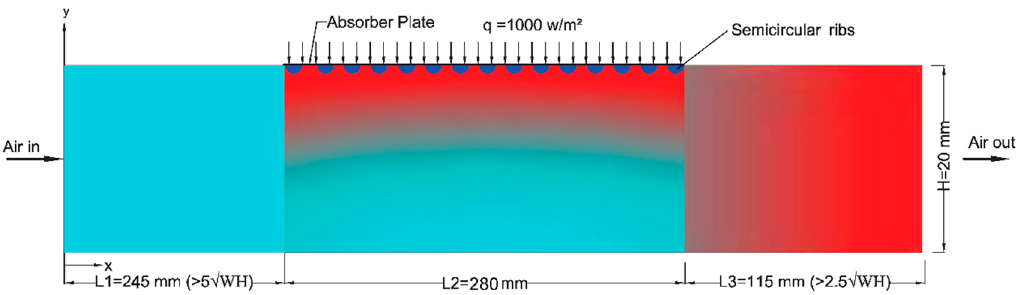
Figure 1. S olution domain. Figure 1. Solution domain.